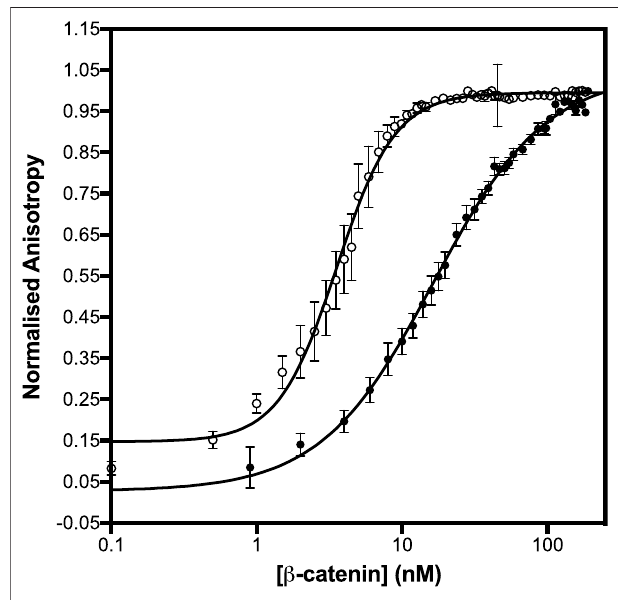
FIGURE 5 | Binding of β -catenin to the unphosphorylated and phosphomimeticformsofAPC abc .Thedissociationconstantsweremeasured by fl uorescence anisotropy using APC abc labelled with fl uorescein at Cys 1501. The unphosphorylated APC abc is shown in black circles and the phosphomimetic, APC abc , in open circles. The data are shown as the mean ± SEM of at least three